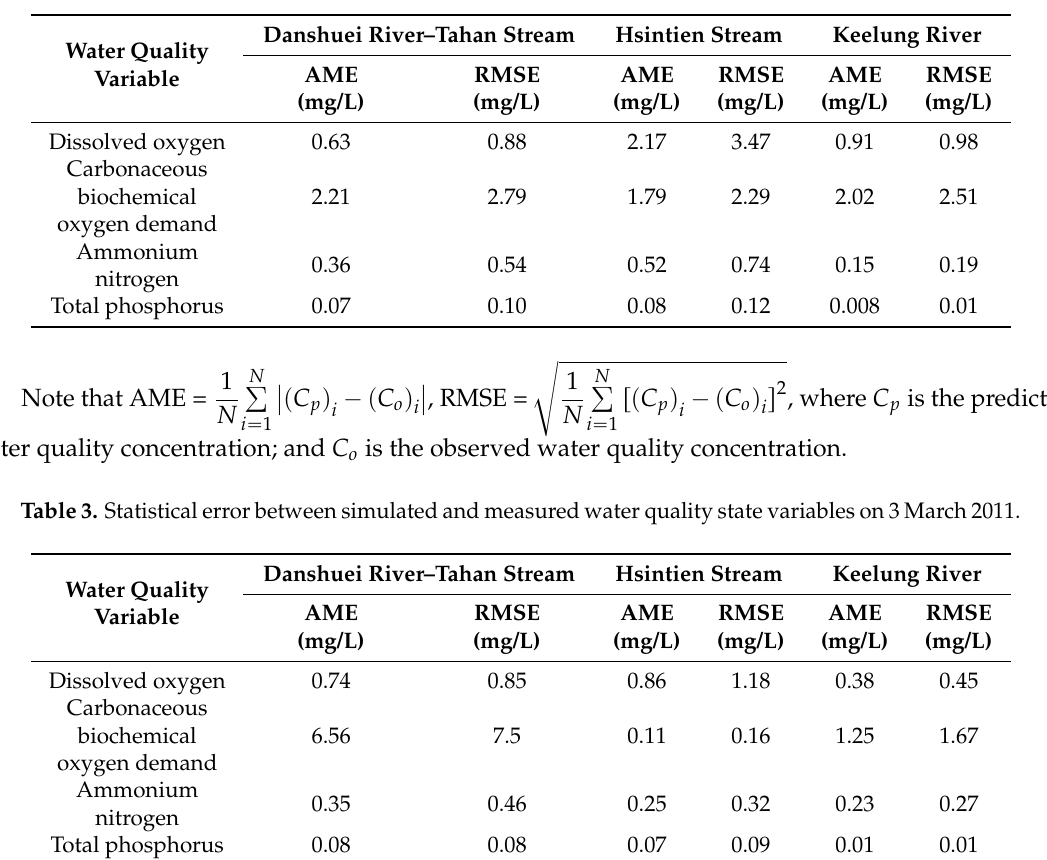
Table 2. Statistical error between simulated and measured water quality state variables on 2 December 2010.